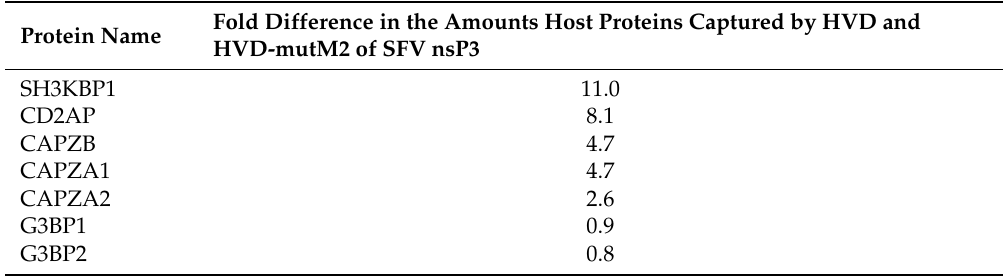
Table 1. Motif M2 of SFV nsP3 HVD associates with multiple